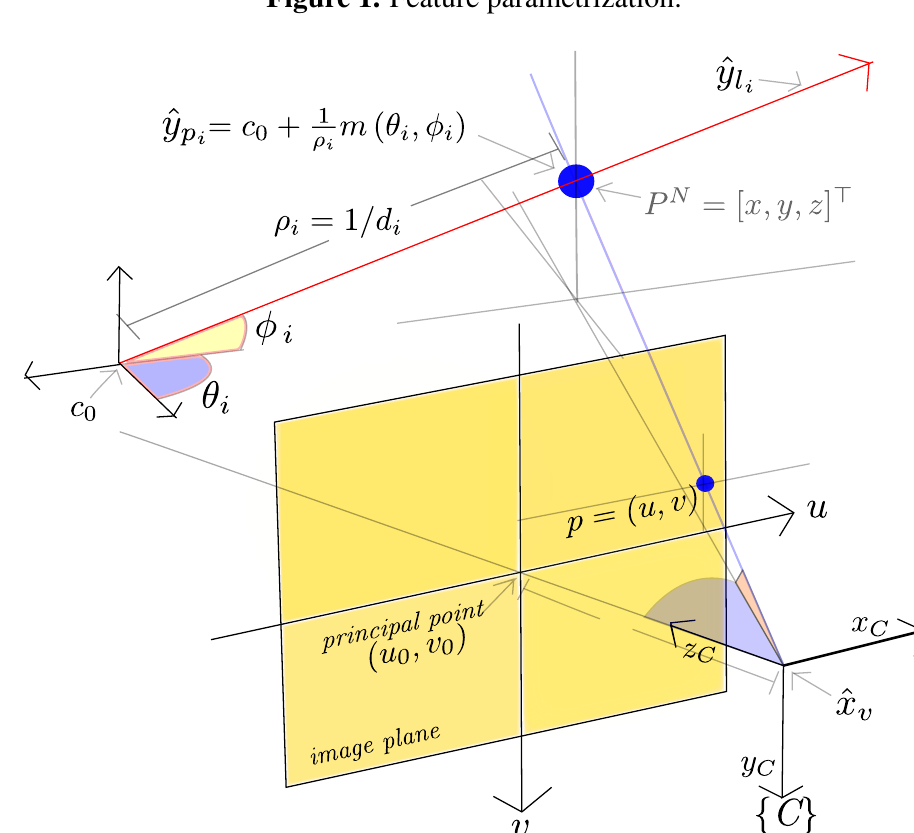
Figure 1. Feature